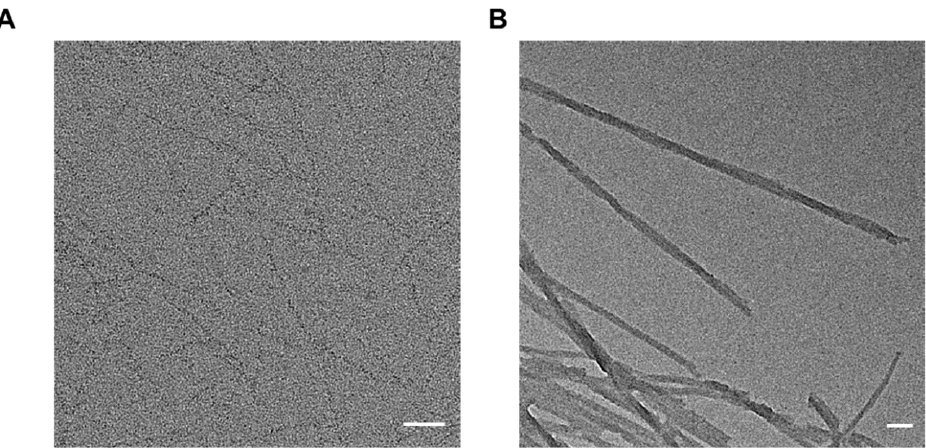
Figure 2. TEM images of self-assembled GL13K in ( A ) 90% ethanol solution and ( B ) pH = 10 buffer. Scale bars are 50 nm.